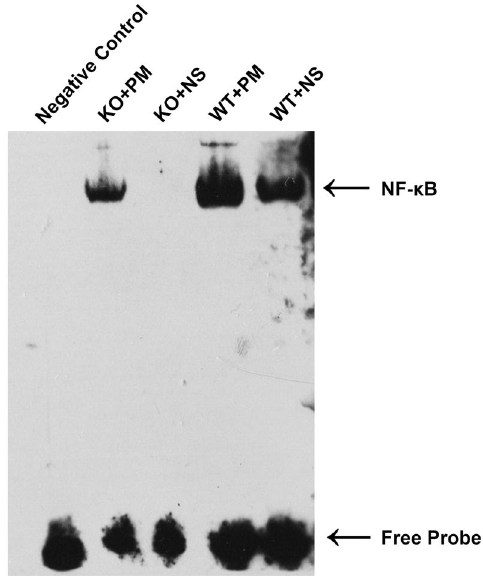
Figure 4. Effect of MyD88 deficiency on activation of NF- κ B after inoculation with S. pneumoniae . NF- κ B binding activity in the cortex in different groups was assessed by EMSA. Bacteria-induced NF- κ B binding was markedly enhanced in infected wild-type mice compared to infected myd88 − / − mice. KO: knockout, PM: pneumoniae meningitis, WT: wild-type, NS: normal saline.